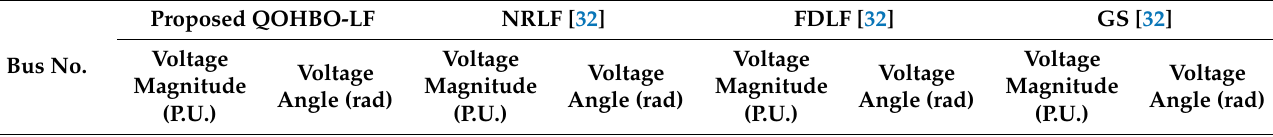
Table 6. Load flow solution for an ill-conditioned 13-bus system under normal conditions.